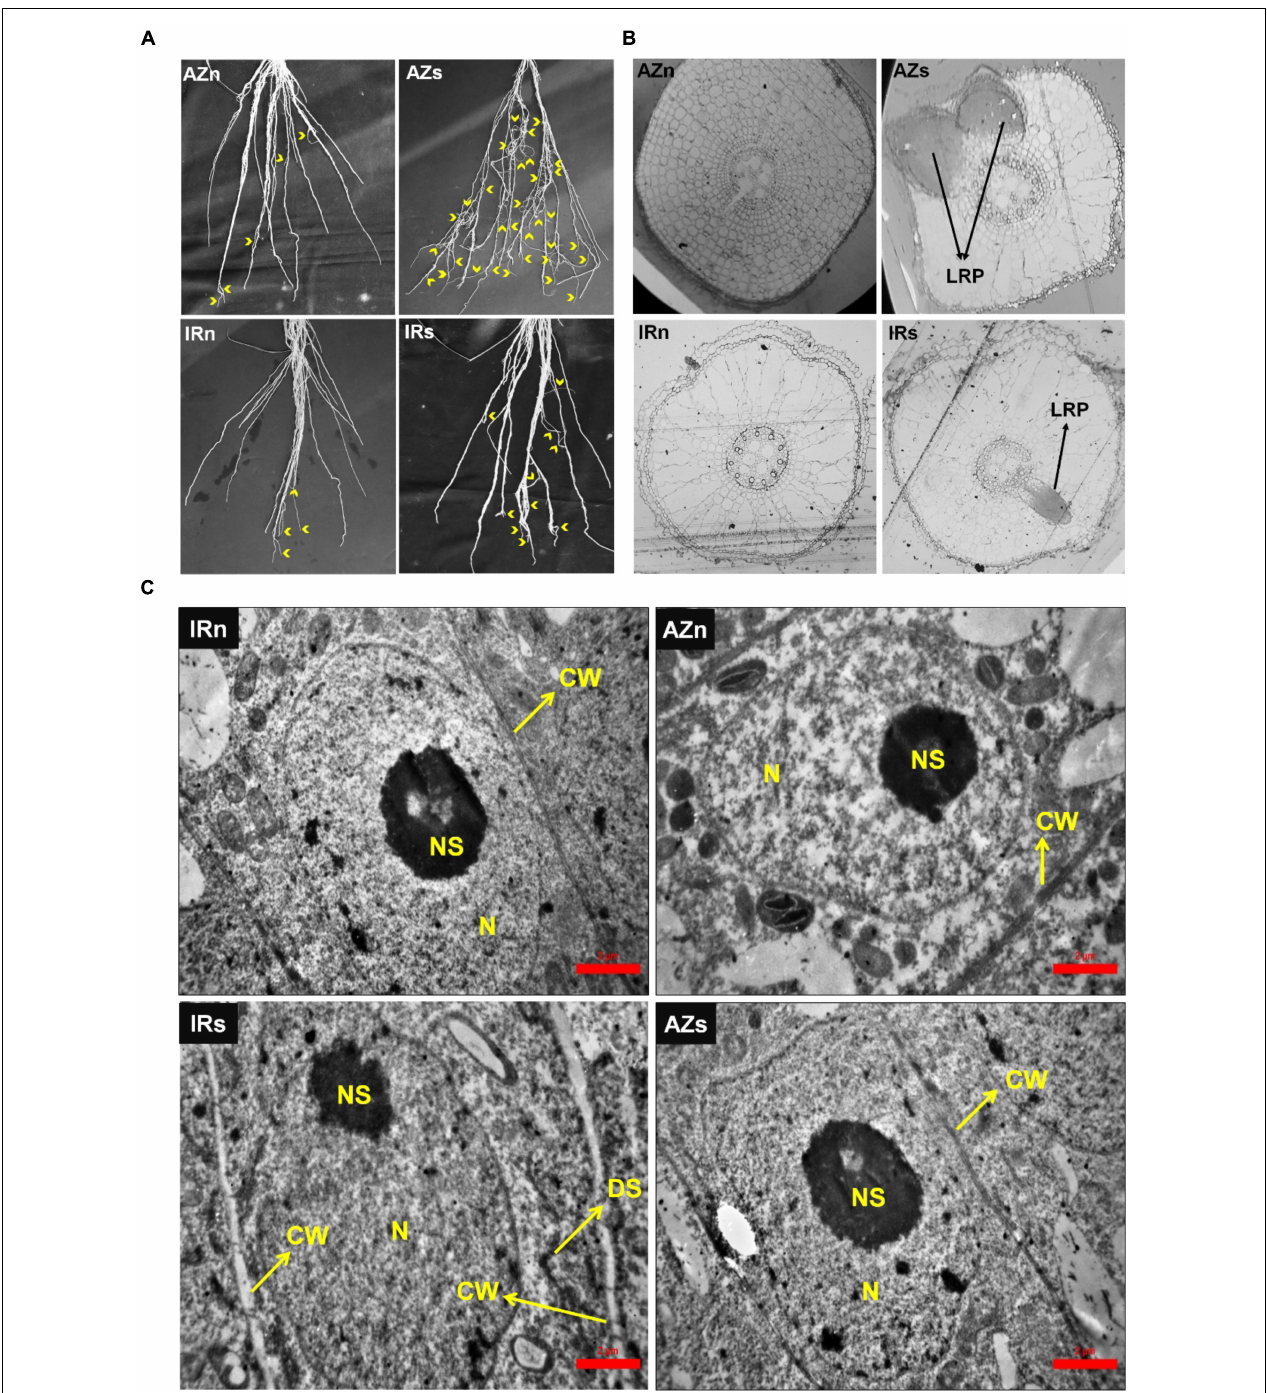
FIGURE 2 | Lateral root expansion and structural and ultrastructural studies of Azucena and IR64 root tips in response to water stress. (A) Lateral root expansion in Azucena and IR64 under normal and stress conditions; Yellow arrows indicate lateral roots. (B) Tissue structural studies of root (zone3) in both genotypes under normal and stress conditions shows the number of lateral root primordia. (C) Ultrastructural studies of root meristematic cells in both genotypes under normal and stress conditions shows cell wall thickening in IR64 in response to stress. IRn, IR64 genotype under normal condition; IRs, IR64 genotype under water-stress condition; AZn, Azucena genotype under normal condition; AZs, Azucena genotype under water-stress condition; Z1, Root Z1; Z2, Root Z2; Z3, Root Z3; CW, cell wall; N, nucleus; NS, nucleolus; DS, dictyosome; LRP, lateral root primordium.